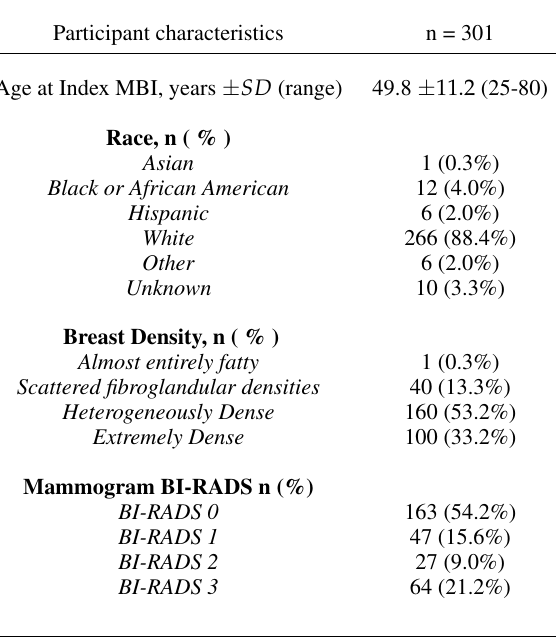
Table 1. Study participant characteristics